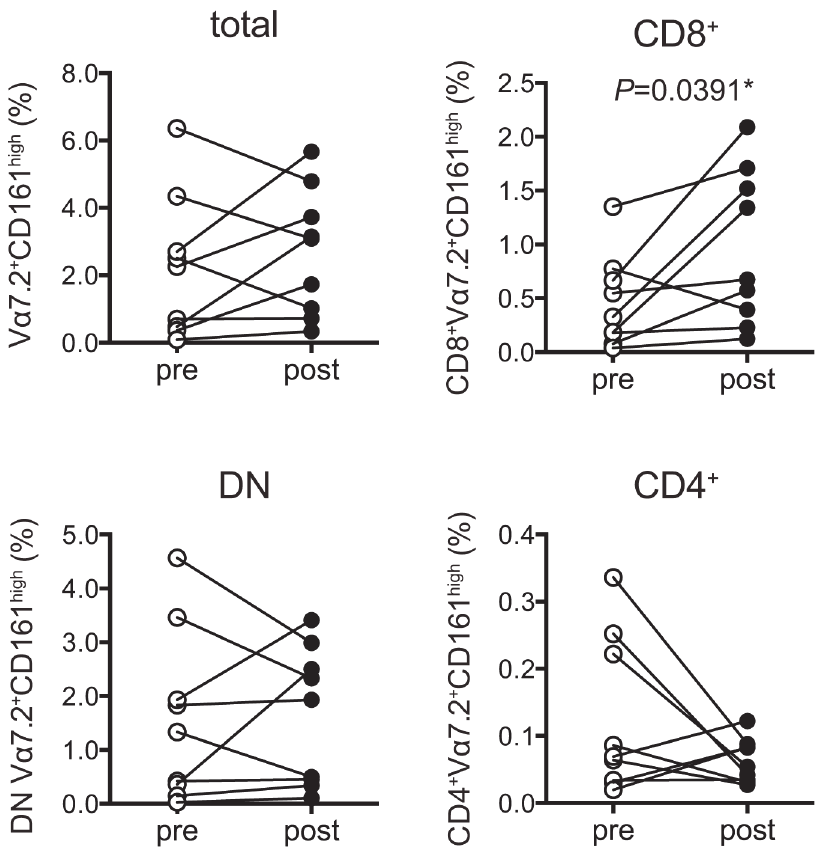
Fig 5. Effect of the daily drug treatment on MAIT cell frequency in FMS. The percentage of total, CD8 + , DN, and CD4 + MAIT cells (V α 7.2 + CD161 high ) within total T cells (CD3 + ) from the same individuals (n = 9) before and after the drug treatment interruption is shown. The statistical significance and P value were with the Wilcoxon matched-pairs signed rank test. Asterisk shows significance. * : P <